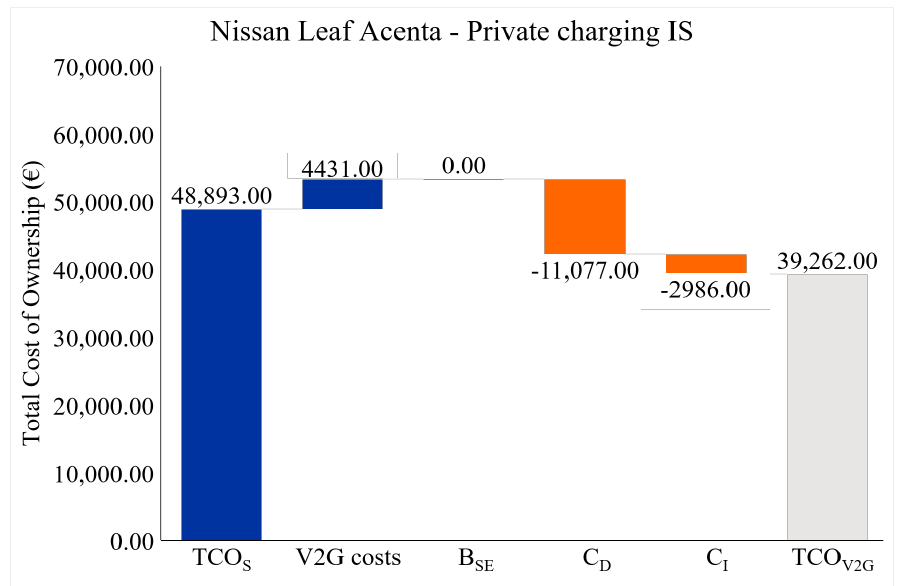
Figure 8. Standard and V2G TCO of a Nissan Leaf in a private charging case providing IS ( TCO S = Standard TCO, B SE = benefit of saved electricity costs from the grid, C D = direct com- pensation, C I = indirect compensation, TCO V 2 G = V2G TCO); source: own compilation.)